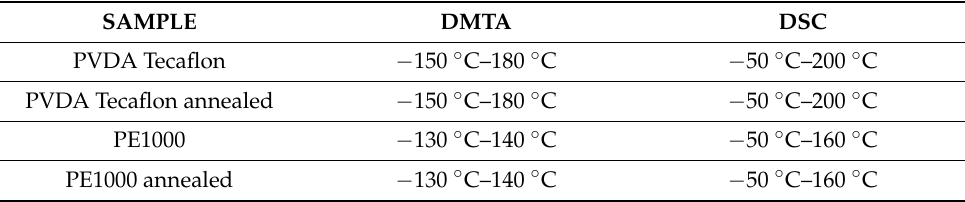
Table 1. The temperature range of the tested materials.